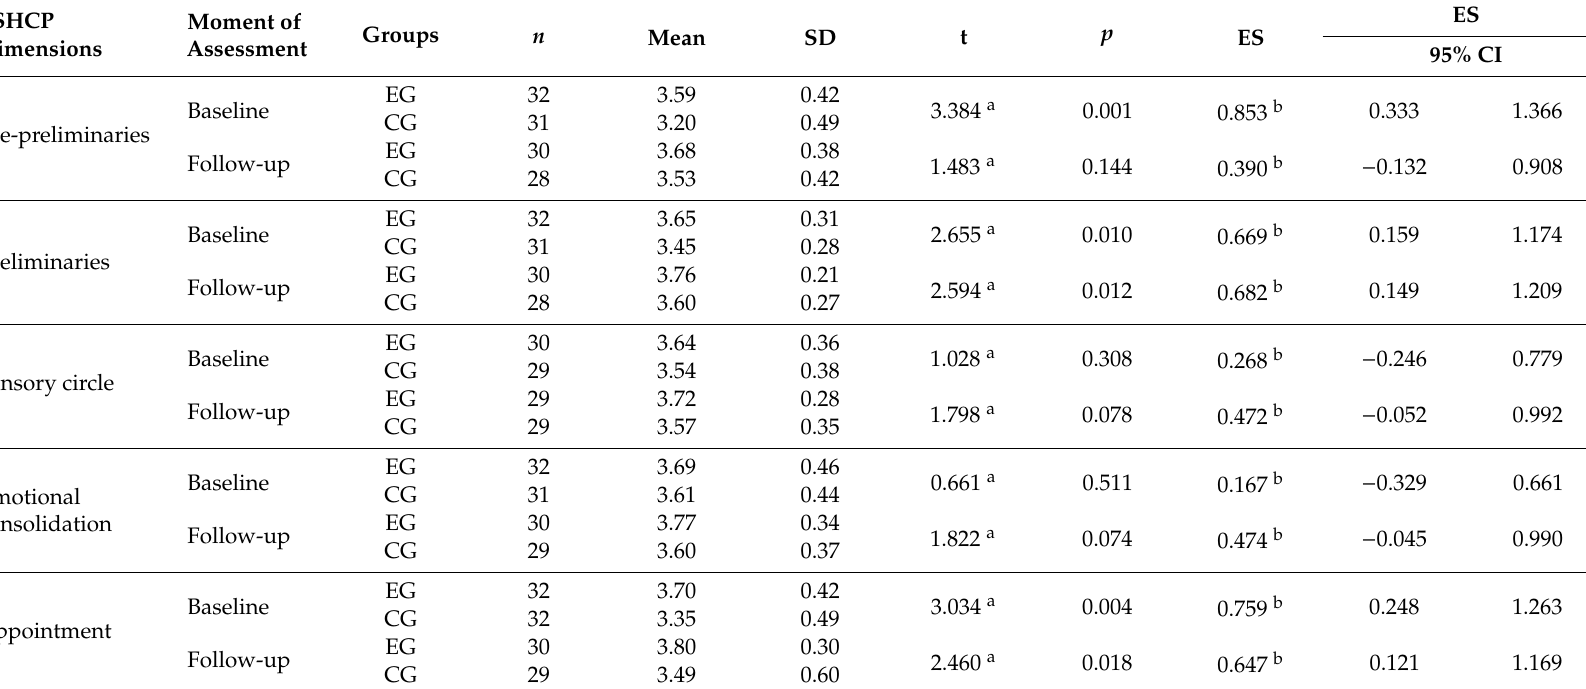
Table 4. Results of the Student’s t-test for independent samples regarding the importance attributed to the Structured Sequence of Humanitude Care Procedures (SSHCP) dimensions by CG and EG students at baseline and